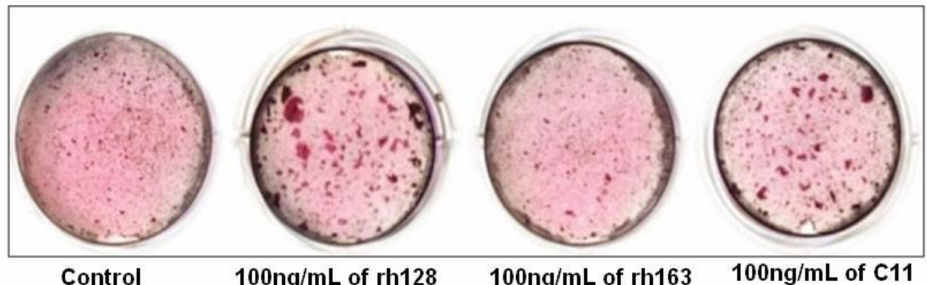
Figure 6. Effect of amelogenin fragment treatment on the mineralization activity of HCEM cells during osteogenic differentiation. Intensity of alizarin red staining in HCEM cells increased following treatment with rh128 or C11 peptide, but there was no obvious difference following treatment with rh163. (Reproduced with permission from